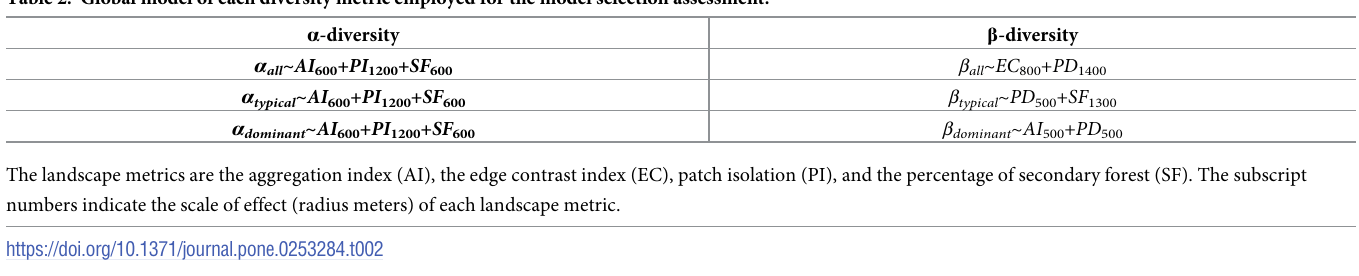
Table 2. Global model of each diversity metric employed for the model selection assessment.